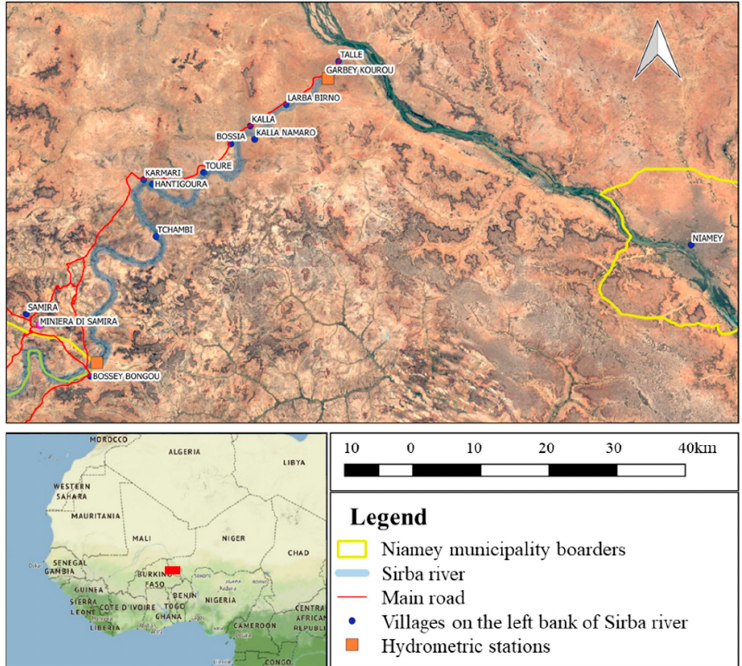
Figure 1. Sirba River in Niger.